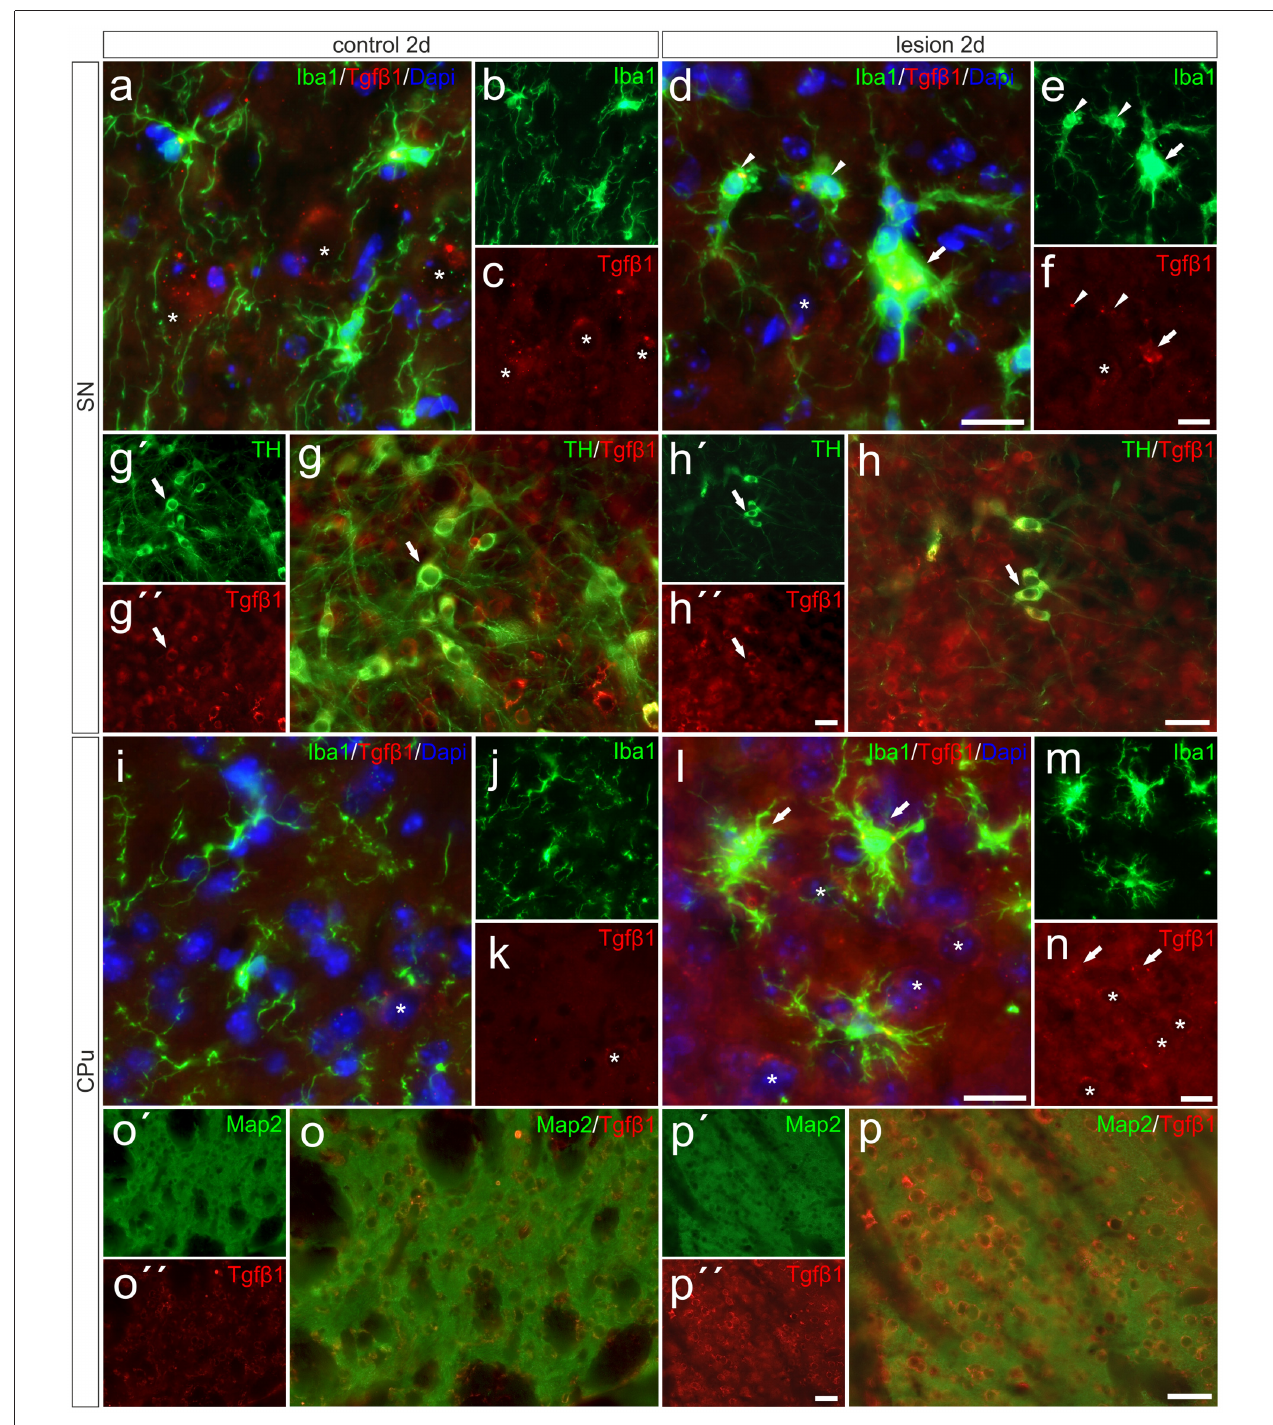
FIGURE 6 | Microglial expression of Tgf β 1 in the SN und the CPu after 6-OHDA injections. Two days after 6-OHDA-induced lesion weak microglial and distinct neuronal Tgf β 1 expression (white asterisks) was observed in SN (A–C,G–G (cid:48)(cid:48) ) and CPu (I–K,O,O (cid:48) ) . However, increased Tgf β 1 immunoreactivity could be detected on the lesioned side after 2 days (H–H (cid:48)(cid:48) ) . Activated microglia (white arrows) showed Tgf β 1 expression in the SN (D–F) , whereas ramified microglia (white arrowheads) showed no Tgf β 1 expression (D–F) . A strong increase in Tgf β 1 immunoreactivity was observed in the lesioned CPu 2 days after 6-OHDA injections (L–N) . Next to activated microglia (white arrows) and neurons (white asterisks) the neuropil displayed prominent Tgf β 1 signals in the lesioned CPu (L,N) . Map2-positive striatal neurons displayed a weak Tgf β 1 immunoreactivity on control sides (O–O (cid:48)(cid:48) ) . After lesion, strong Tgf β 1 signals could be observed in Map2-positive neurons in the CPu (P–P (cid:48)(cid:48) ) . Representative images from three different animals are shown. Scale bars indicate 20 µ m (A–F,I–N) and 50 µ m (G,H,O,P) .